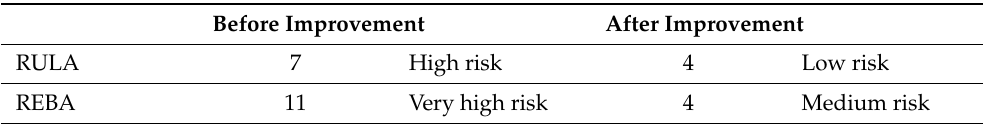
Table 12. RULA and REBA comparison.